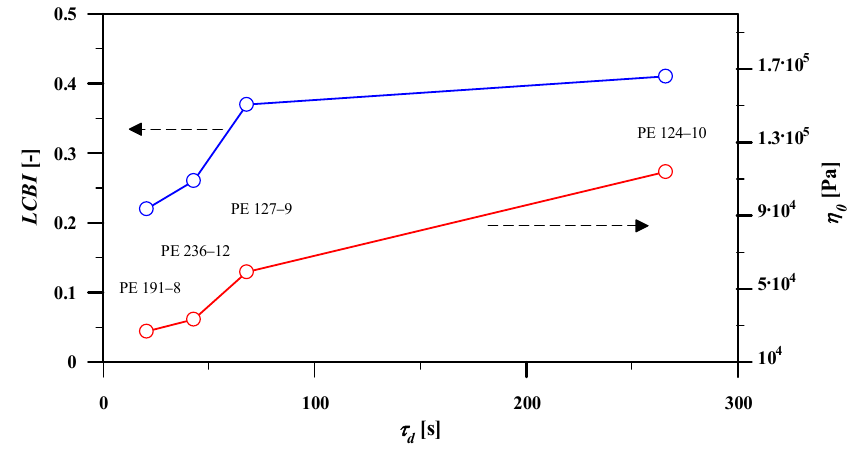
τ η and 0 (Equation (10)). Figure 8. Relationship between PDI, LCBI (Equation (8)), and τ d and η 0 (Equation